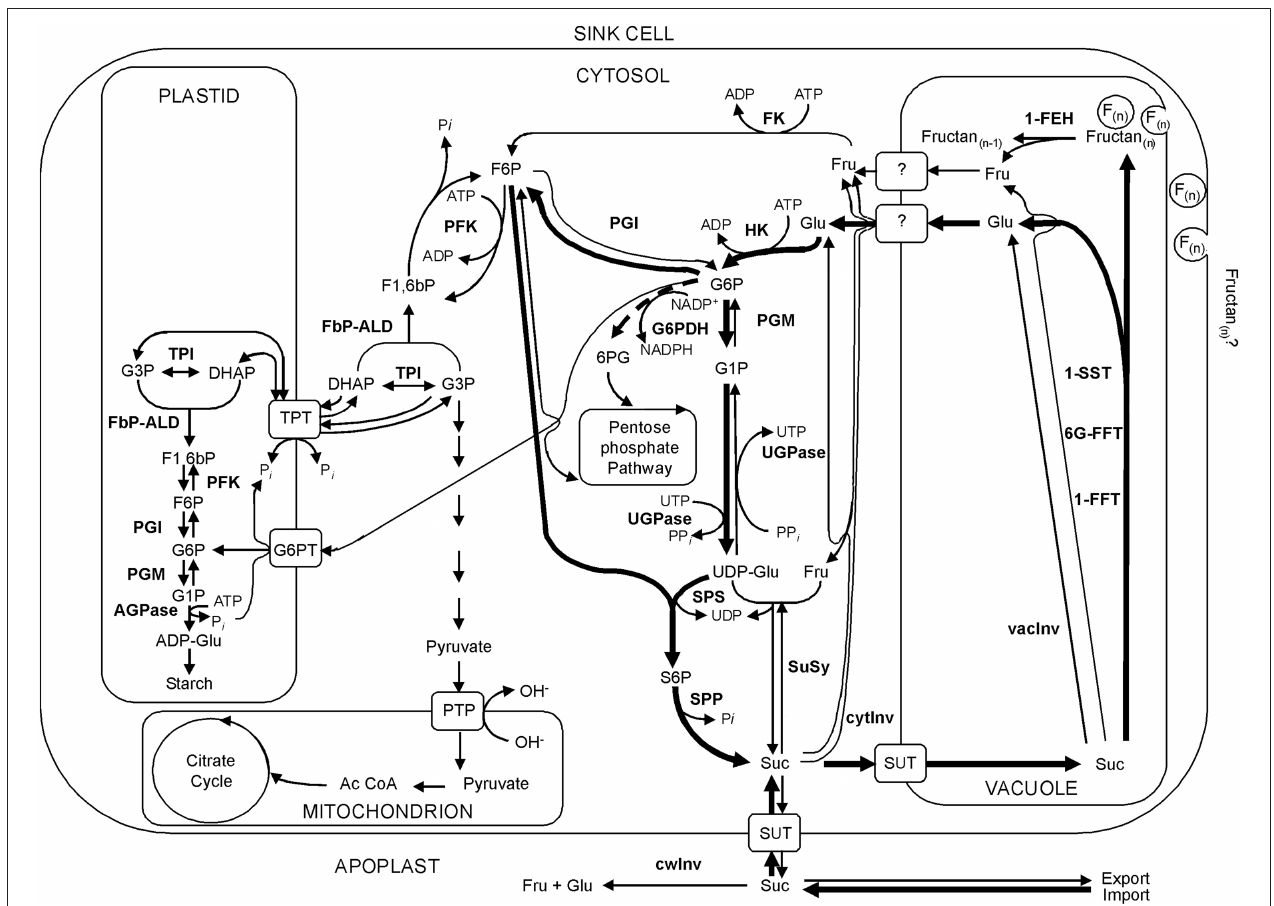
FIGURE 1 | Model for fructan and primary carbohydrate metabolism in sink cells of perennial ryegrass. Bold arrows indicate preferential fluxes of carbon to induce fructan accumulation. The bold dotted arrow indicates the competition for G6P by G6PDH. Abbreviations: Ac Co A, acetyl coenzyme A; ADP, adenosine triphosphate; ADP-Gluc, adenosine triphosphate glucose; AGPase, adenosine diphosphate glucose pyrophosphorylase; ATP, adenosine triphosphate; DHAP, dihydroxyacetone phosphate; FbP-ALD, fructose-1,6-bisphosphate dependent aldolase; F1,6bP, fructose-1,6-bisphosphate; F6P, fructose-6-phosphate; FK, fructokinase; Fru, fructose; G1P, glucose-1-phosphate; G3P, 3-phospho glycerate; G6P, glucose-6-phosphate; G6PT, glucose-6-phosphat translocator; Glu, glucose; HK, hexokinase; 6PG, 6-phospho gluconate; NADP + , nicotinamid adenine dinucleotide phosphate( ox , ); NADPH, nicotinamid adenine dinucleotide phosphate( red , ); PFK, phosphofructokinase; PTP, pyruvate transport protein; SPP, sucrose phosphate phosphatase; SPS, sucrose phosphate synthase; Suc, sucrose; SuSy, sucrose synthase; SUT, sucrose transporter; TPI, triosephosphate isomerase; TPT, triose-phosphate/phosphate translocator; UDP, uracyl diphosphate; UDP-Glu, uridinyl diphosphate glucose; UTP, uridine